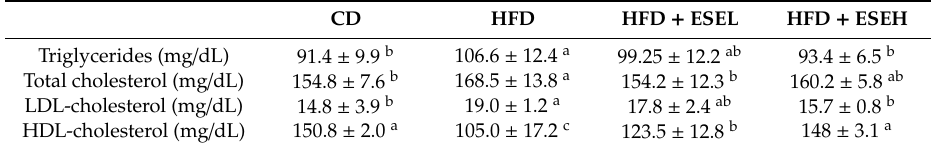
Table 1. E ff ects of ESE administration on blood parameters in HFD-induced obese mice.